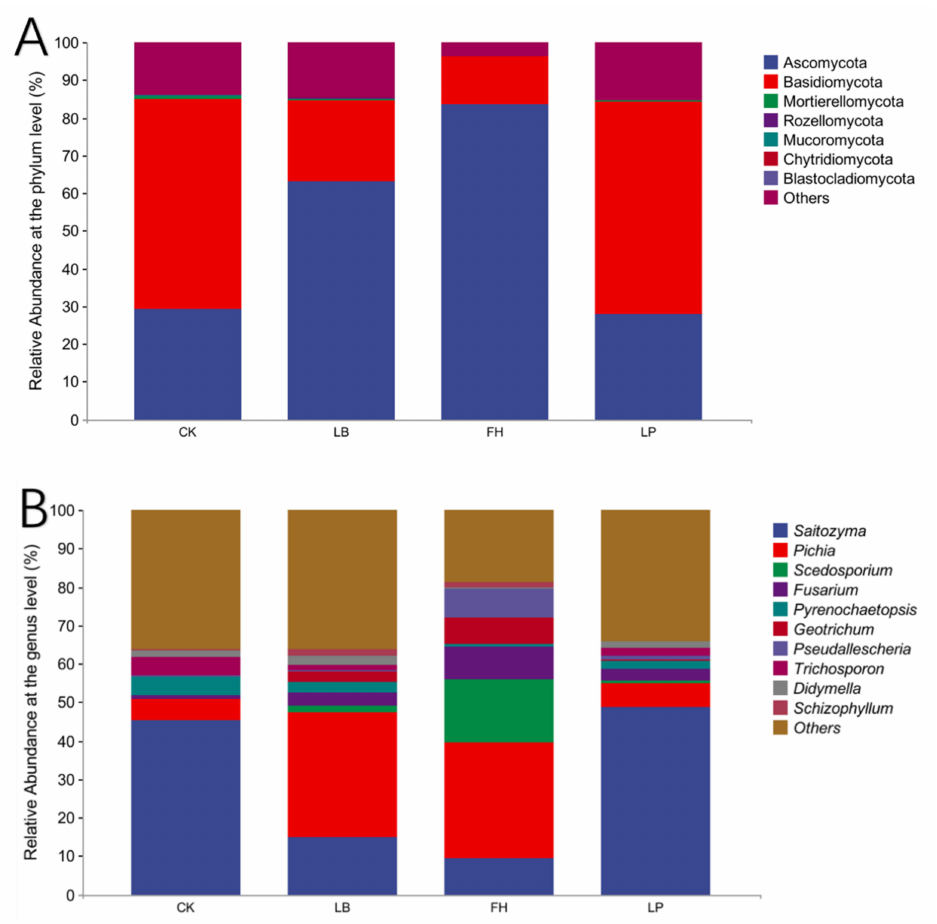
Figure 4. The epiphytic fungal community in M. aquaticum silage after 60 d of ensiling. The bacterial communities are shown at the phylum level ( A ) and the genus level ( B ). CK, control; LB, Lactobacillus buchneri ; LP, Lactobacillus plantarum ; and FH, combination of LB and